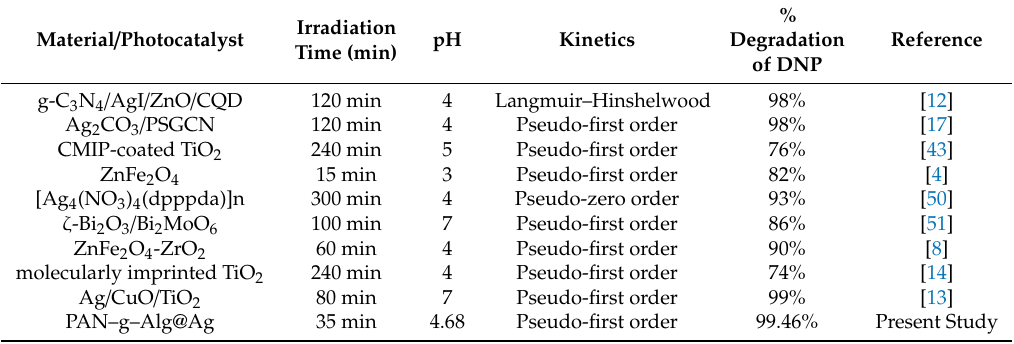
Table 5. Comparison of degradation e ffi ciency of PAN-g-Alg@Ag NC with previously reported studies. Material /